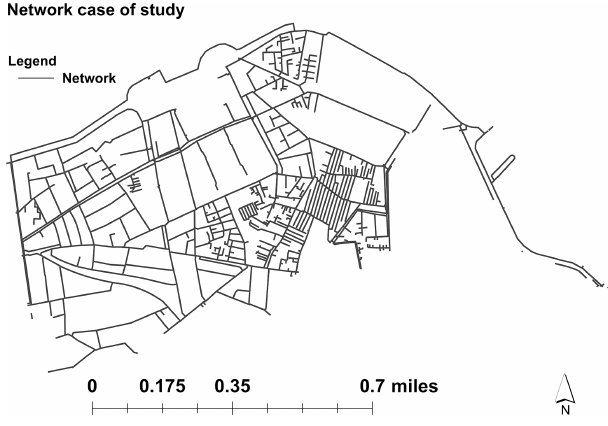
Figure 1. Delimitation of the study area. Please note that 1mi =